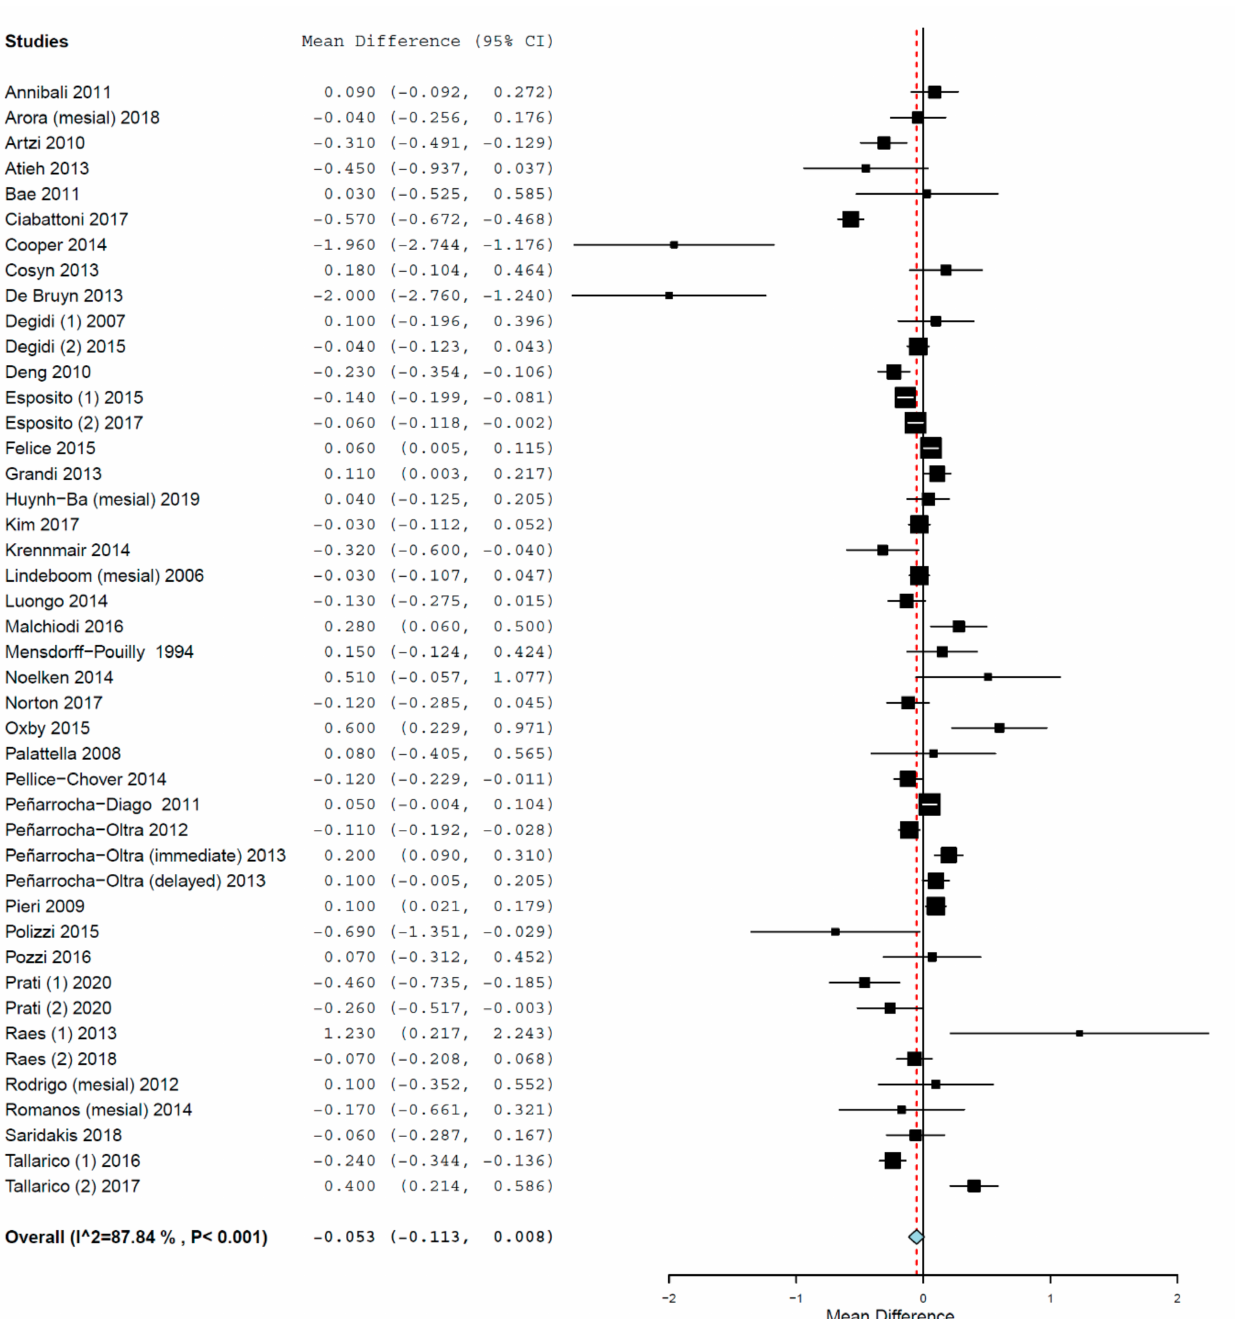
Figure 6. Forest plot for the event ‘marginal bone